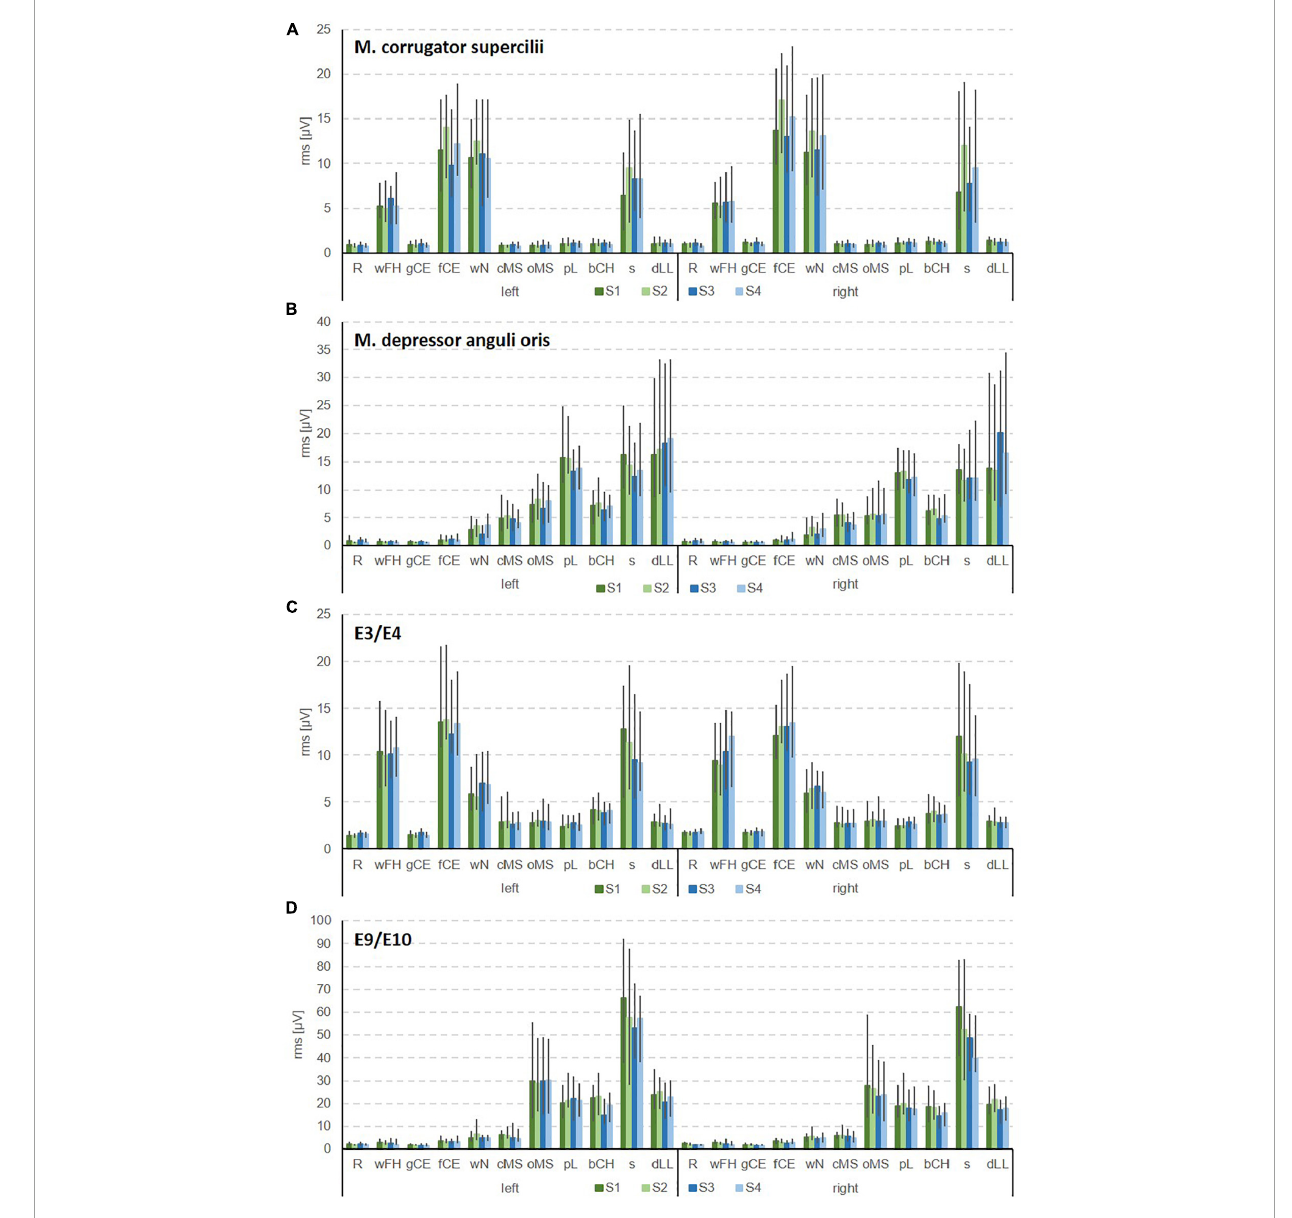
FIGURE3 Examples for the bilateral sEMG for the Fridlund scheme (A,B) and the Kuramoto scheme (C,D) . (A) Recordings from M. corrugator supercilii. (B) M. depressor anguli oris. (C) E3/E4 in the frontal area. (D) E9/E10 in the chin area. R, face at rest (no movement); wFH, wrinkle forehead; gCE, closing the eyes normally (gentle eye closure); fCE, closing the eyes forcefully (forceful eye closure); wN, nose wrinkling; cMS, smiling with closed mouth; oMS, smiling with open mouth; pL, lip puckering (pursing lips); bCH, blowing-out the cheeks (cheek blowing), s, snarling; dLL, depressing lower lip; S1, session 1 at t1; S2, session 2 at t1; S3, session 1 at t2; S4, session 2 at